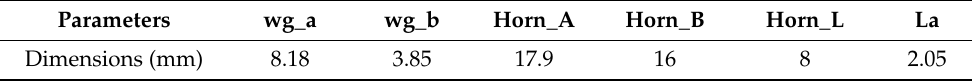
Table 1. Dimensions of 3D-printed horn antenna coated with copper tape.